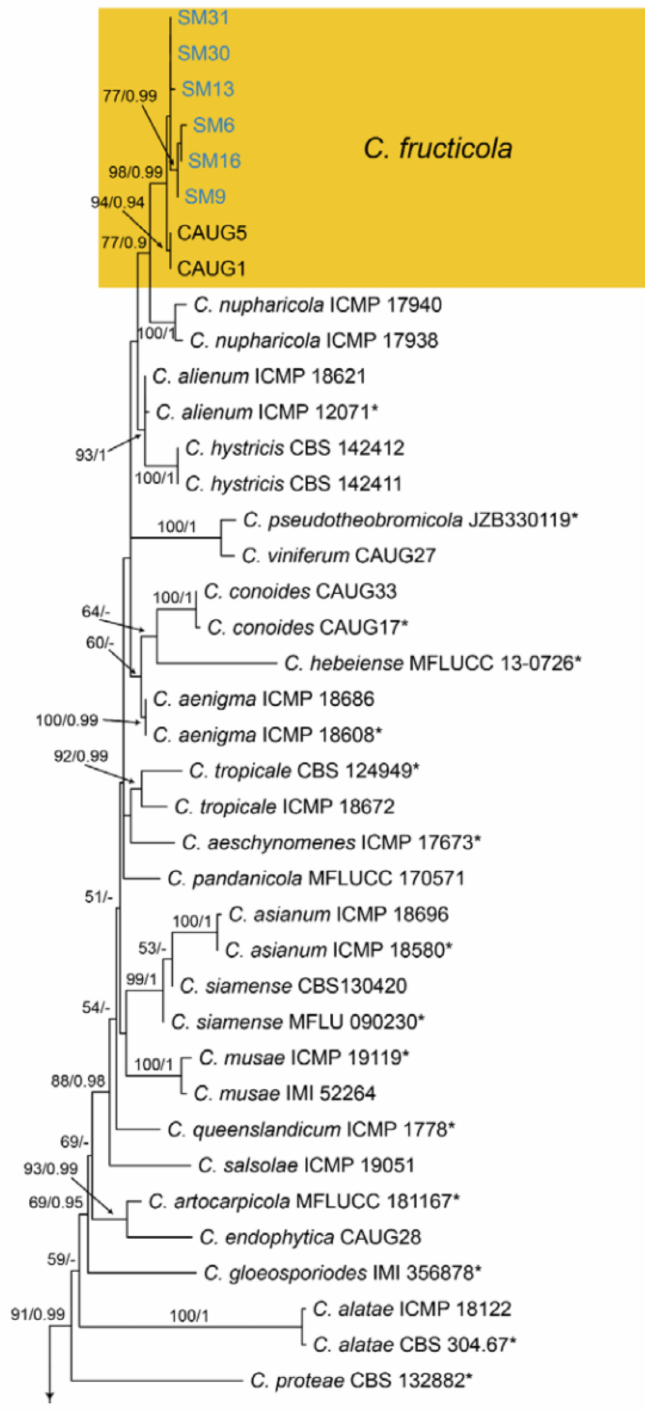
Figure A13. Cont